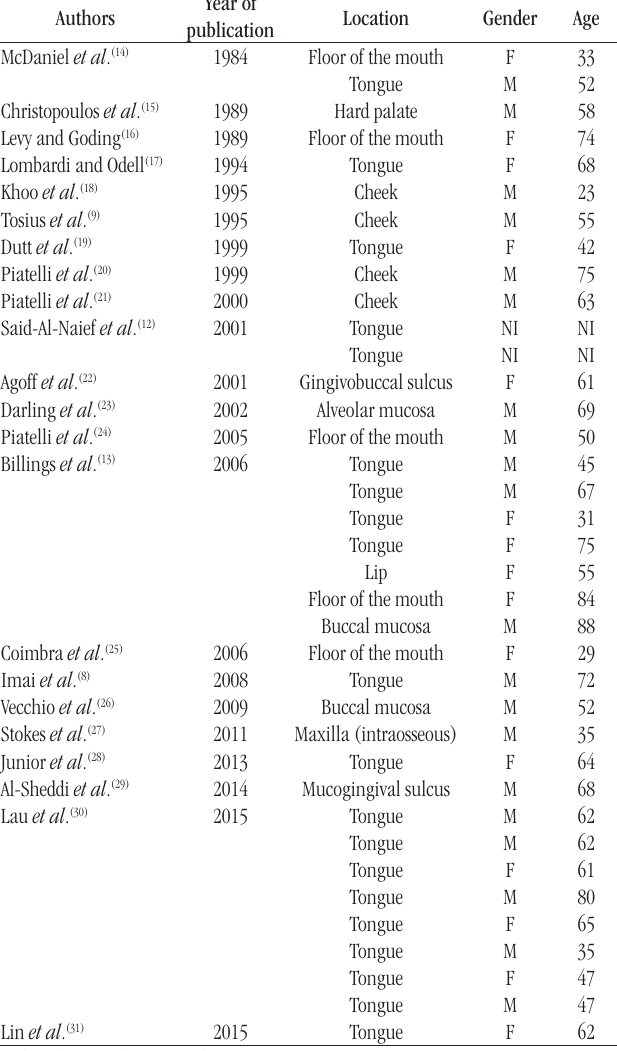
taBLE − Summary of spindle-cell/pleomorphic lipoma of the oral region reported in the English-language